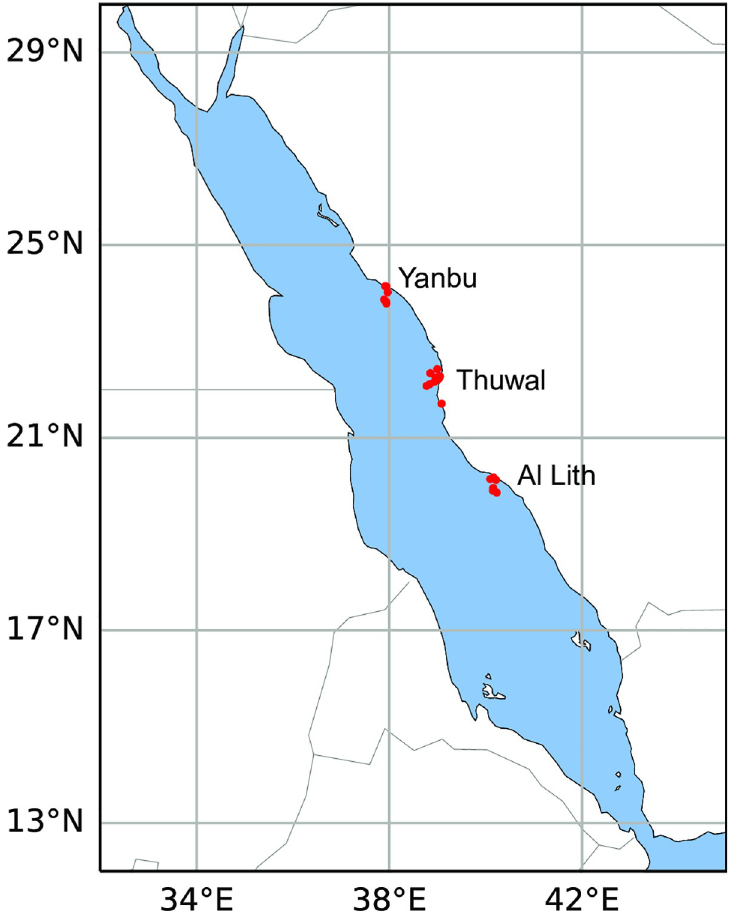
Fig 1. Sites surveyed for coral disease in three regions (Yanbu, Thuwal, Al Lith) along the Saudi Arabian coast within the central Red Sea in Oct-Nov, 2015. Red dots indicate survey sites within each of the regions. Coral reefs (not shown on map) can be found along its entire